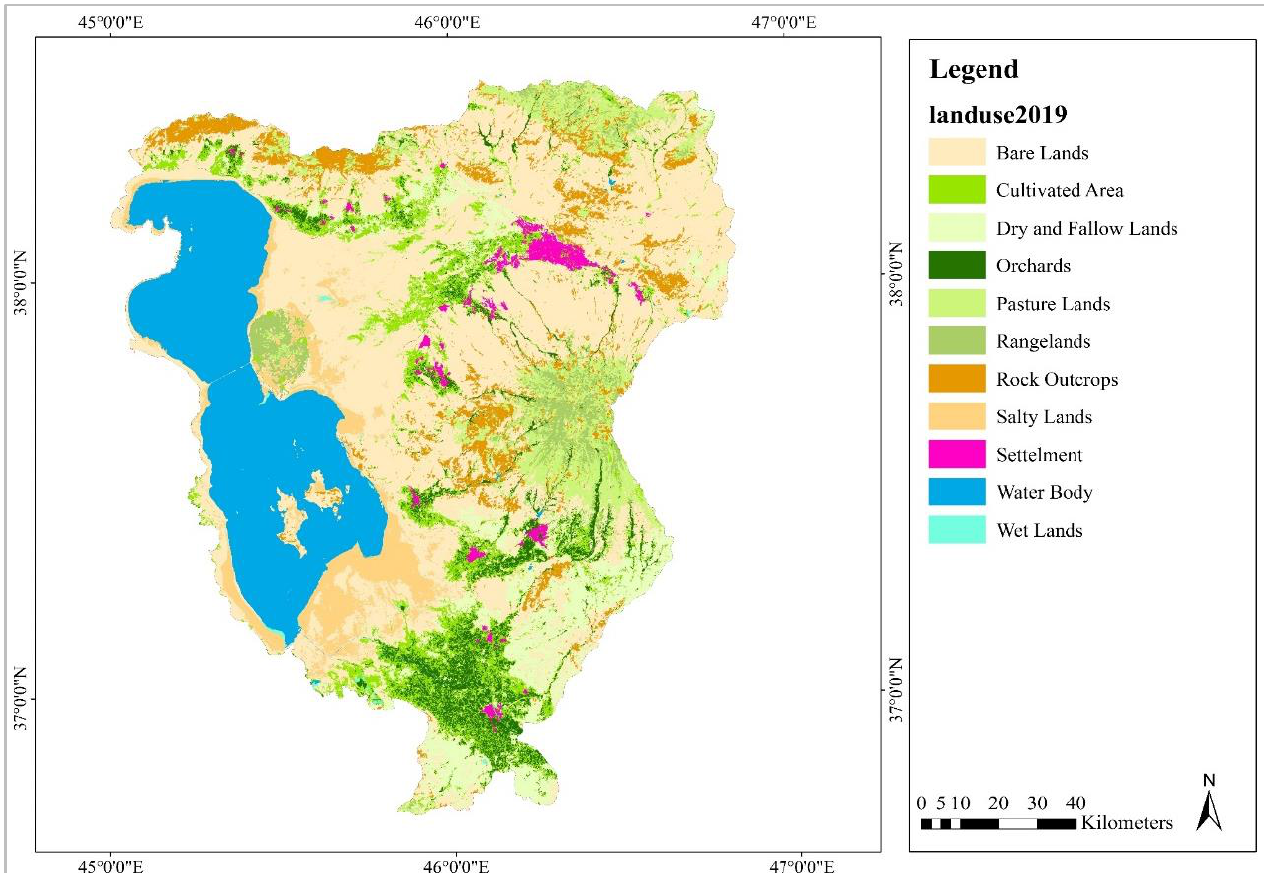
Figure 3. Land-use map of the study area for 2020.